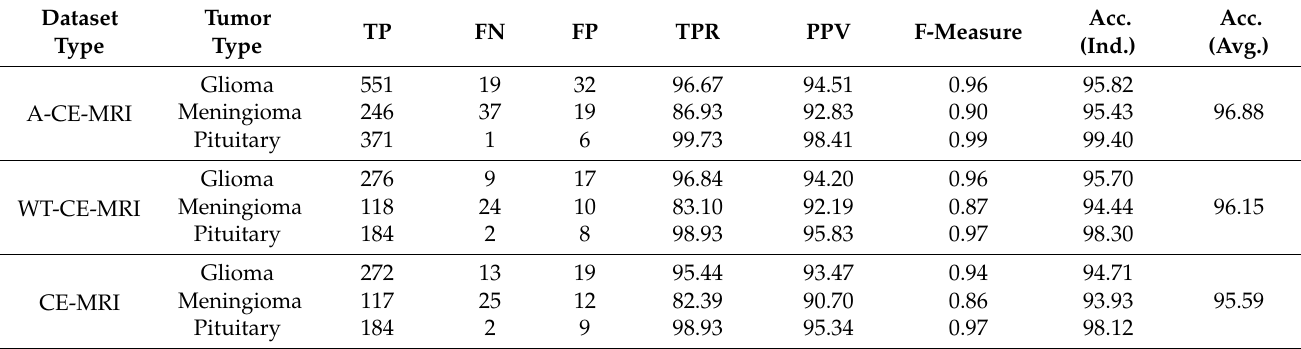
Table 5. UL-DLA results using SoftMax classifier for augmented (A-CE-MRI), wavelet transform based (WT-CE-MRI), and intensity normalized (CE-MRI)